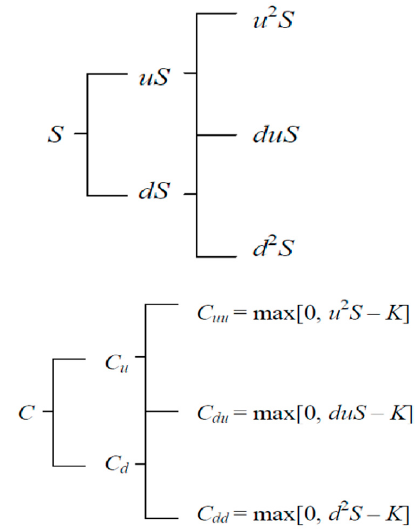
Figure 3. Algorithm of real options analysis under the binomial model according to (Cox et al. 1979).